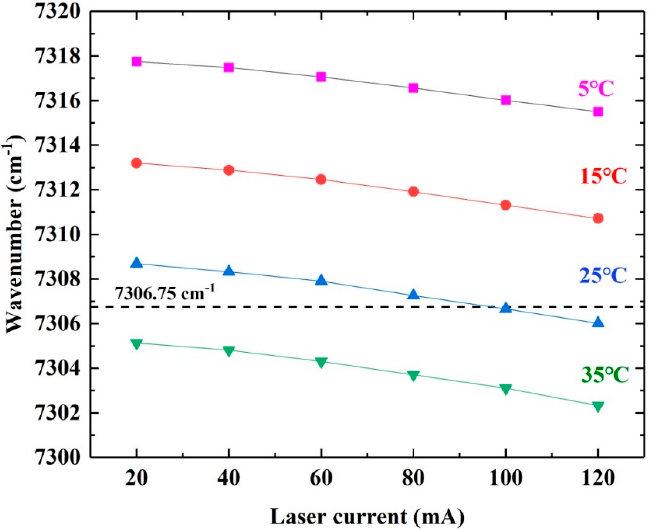
Figure 5. The laser wavelengths as a function of laser driving current at different temperatures.